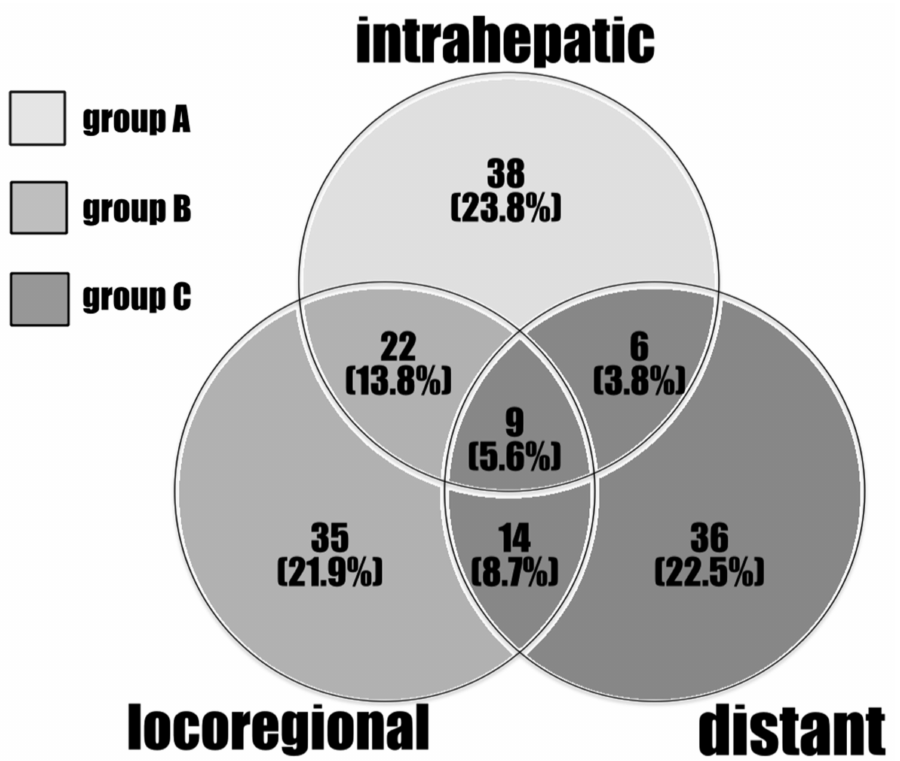
Figure 2. The distribution of recurrent tumors based on their locations and numbers.